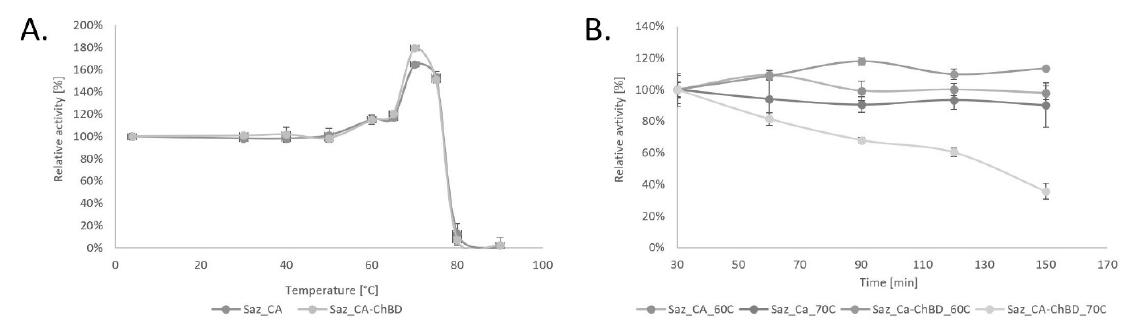
Figure 2. Thermostability of Saz_CA variants. ( A ) Thermostability of Saz_CA variants during 30 min incubation at different temperatures. ( B ) Thermostability time-course during incubation of Saz_CA variants at 60 °C and 70 °C for up to 150 min.